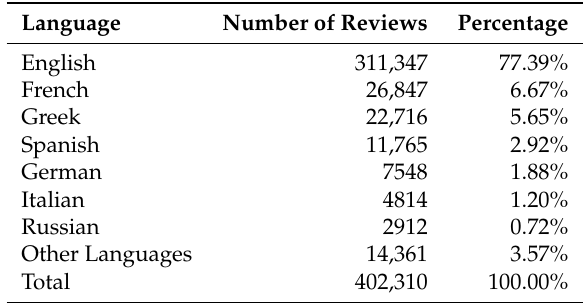
Table 3. Number of reviews per language of Athens’ Airbnb listings on 19th November